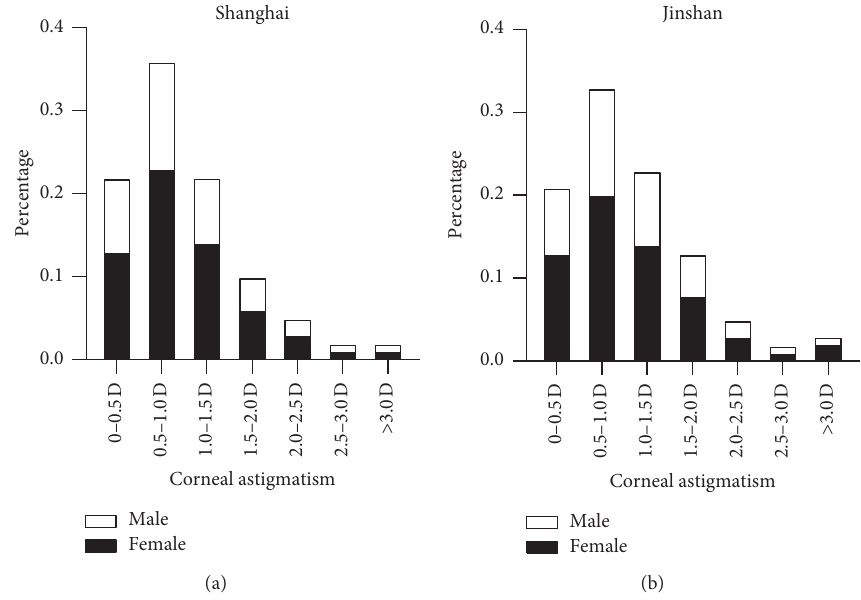
Figure 3: Distribution of corneal astigmatism in the total Shanghai population.